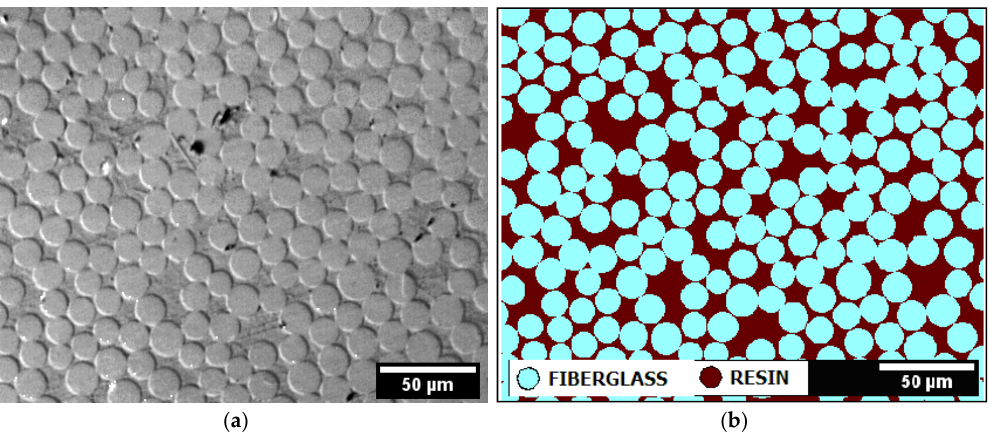
Figure 15. Microstructure image of sample C3 on its flat side surface, 200×. Few chipping of fiber fragments and binder are visible ( a ) on the right side and ( b ) the same area with a colored binary mask, which enables precise measurements to be taken.